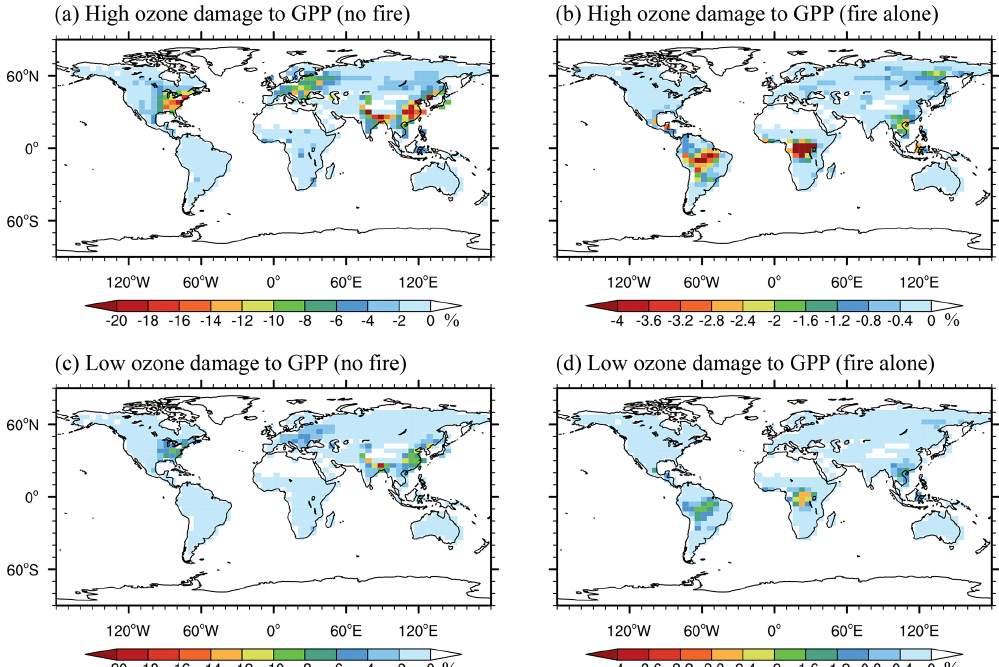
Figure 4. Annual percentage of reductions in GPP caused by O 3 from (a, c) non-fire sources and (b, d) fire sources alone with (a, b) high and (c, d) low O 3 sensitivities. Please note the differences in color scales.